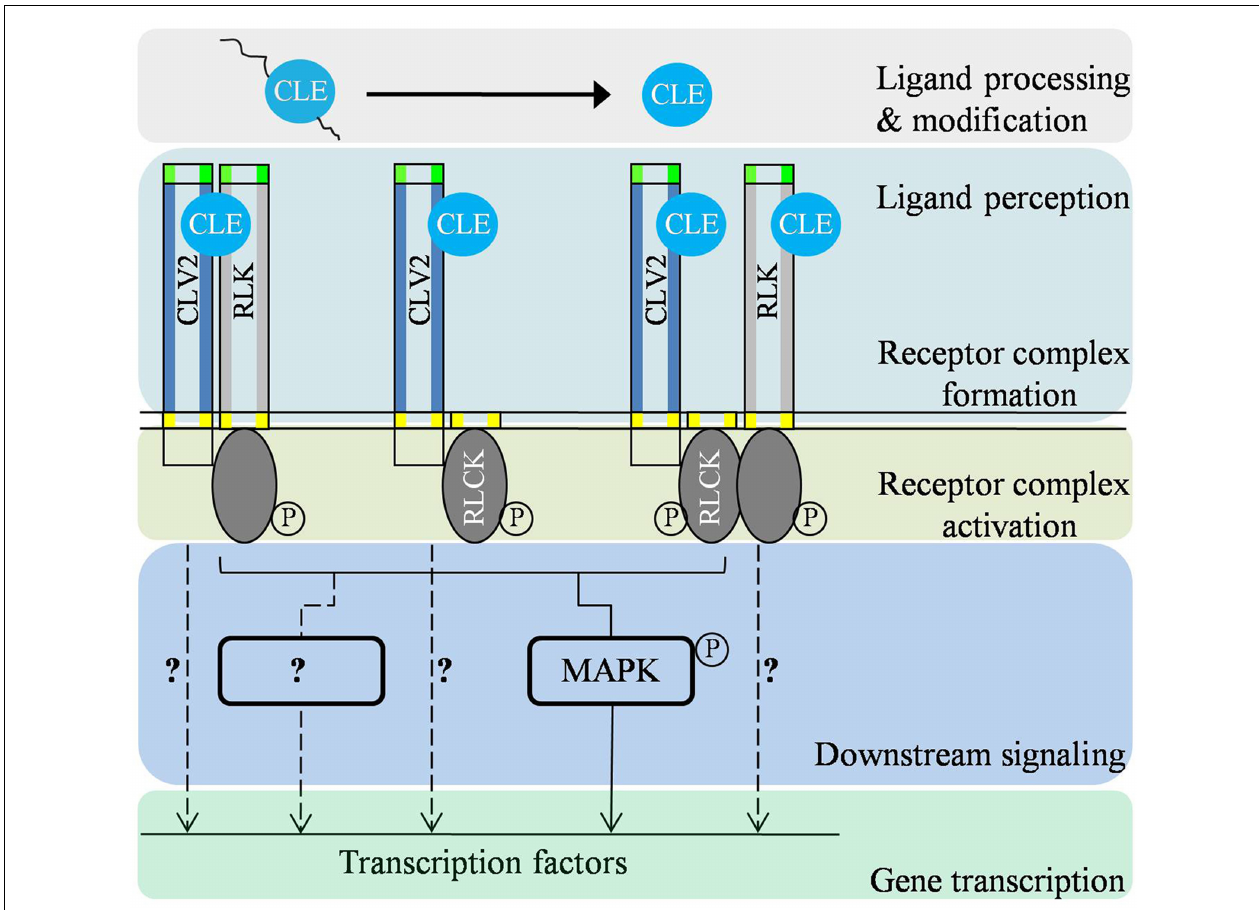
FIGURE 2 | Predicted signal transduction cascades of CLV2-associated receptor complexes in modulating different biological processes. Firstly, CLE is proteolytically processed and/or post-translationally modified to be a functional CLE signaling peptide. On the plasma membrane, CLV2 forms receptor complexes with RLK(s)/RLCK(s) and perceive the putative ligand signal. In the cytoplasm, the ligand signal is modulated through regulation of phosphorylation status of the receptor complex. Upon activation, CLV2-associated receptor complexes subsequently transmit the signal to downstream signaling components such as mitogen-activated protein (MAP) kinases and possibly other yet-unidentified components (?). There also may be other mechanisms mediating the signaling output of CLV2-associated complexes (dotted lines with?).